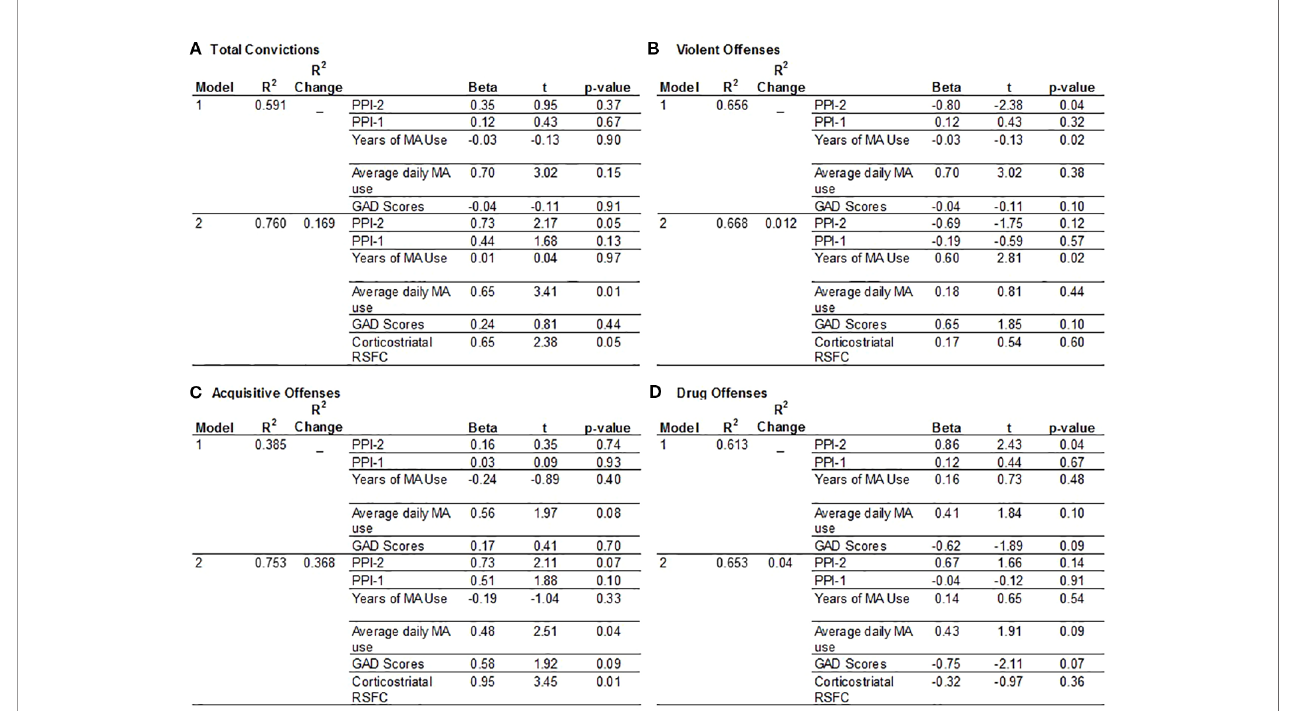
FIGURE 2 | Hierarchical multiple regression analysis to predict criminal offenses. The model includes factors hypothesized to contribute to a history of criminal convictions in the MA group. Model 1 includes PPI-1 and PPI-2 scores, Years of MA use, Average daily MA use and GAD-7 anxiety scores. Model 2 includes variables listed in Model 1 plus corticostriatal RSFC values. (A) Total Convictions: RSFC values improved the model by 1.69%. The most signi fi cant predictors are PPI-2 scores, daily MA use and corticostriatal RSFC. (B) Violent Offenses: RSFC values only improved the model by 1.2% and the most signi fi cant predictors of violent offenses are PPI-2 and years of MA use. (C) Acquisitive Crimes: RSFC values increased the model by 36.8.5% and indicates that greater daily MA use and greater corticostriatal RSFC are signi fi cant predictors of acquisitive crimes. (D) Drug Offenses: The independent variables accounted for the least amount of variance associated with drug offenses with greater PPI-2 scores associated with more drug